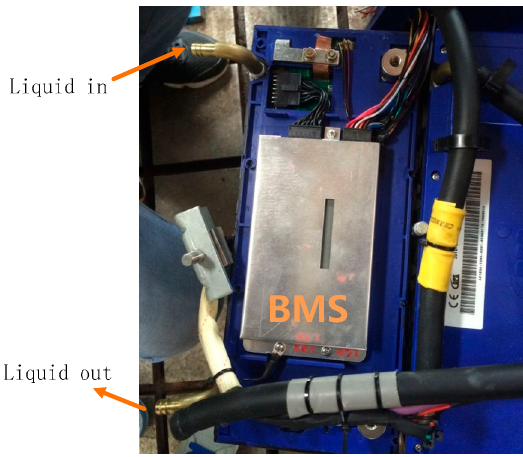
Figure 12. Cell with circulating liquid inside.